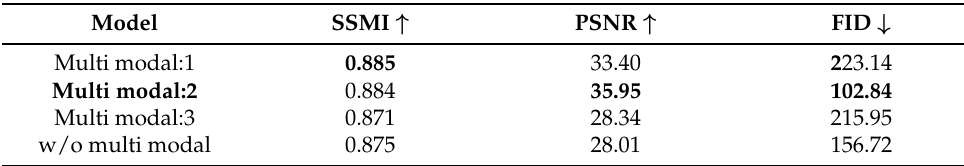
Figure 7. The results and details of comparison of the influence of multi-modal discriminator. ( a ) Origin; ( b ) Without; ( c ) With. Table 4. Comparison of different multi-modal modes in ColorMedGAN. Multi modal:1 denotes element-wise addition after element-wise multiplication and Sigmoid activation function; Multi modal:2 denotes concatenate directly; Multi modal:3 denotes element-wise multiplication and Sig- moid activation function.